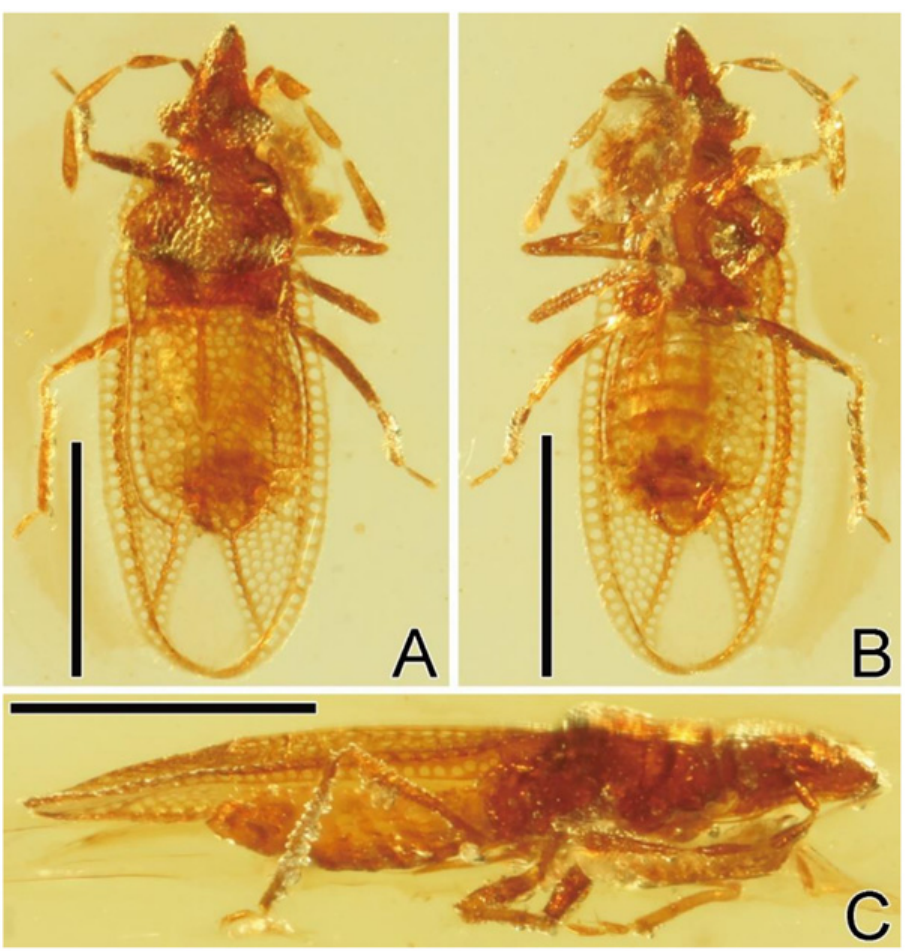
Figure 1. Habitus images of Burmavianaida anomalocapitata gen. et sp. nov. from mid-Cretaceous Kachin amber (holotype, AMNH Bu-SY29): dorsal, ventral and lateral views ( A – C ). Scale bars: 0.5